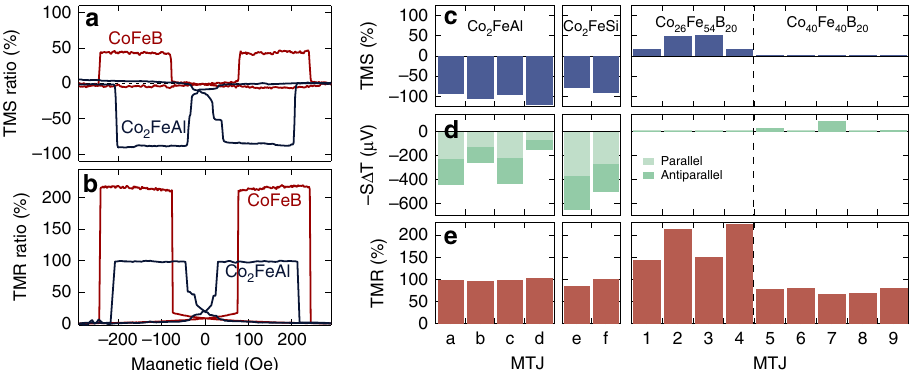
Fig. 4 Comparison of Heusler compound to Co-Fe-B MTJs. a The TMS ratios (determined at 150 mW laser power) of Co 2 FeAl is twice as high compared to Co 26 Fe 54 B 20 and possesses an inversed sign. b For the TMR ratios (at 10 mV bias voltage) of the same MTJs the opposite is found. c TMS ratios for various Co 2 FeAl and Co 2 FeSi based MTJs in comparison to MTJs with two different Co-Fe-B compositions. d Corresponding Seebeck-voltages − S Δ T at a laser power of 150 mW in the P and AP con fi guration of the MTJs. e TMR ratio of the MTJs at 10 mV bias. Only the Heusler based MTJs simultaneously exhibit a large Seebeck voltage and high TMS ratio